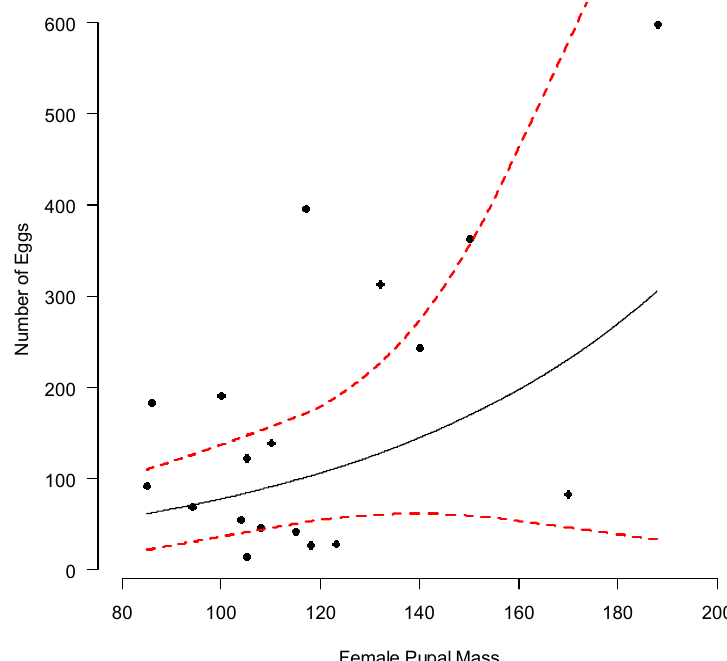
Figure 4. Regression of total number of eggs laid by S. frugiperda females ( y -axis, back-transformed to linear) using female pupal mass (mg) as the predictor ( x -axis). Heavier females laid more eggs than lighter females. Filled circles represent the raw data, with the solid black line representing the regression and the dashed red lines represent the 95% credible intervals.